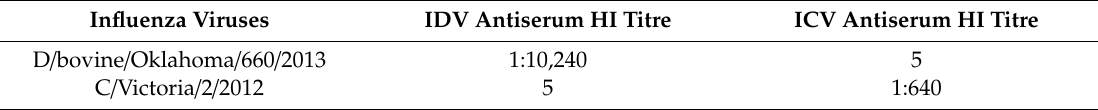
Table 1. HI cross-reactivity between IDV and ICV against hyper immune